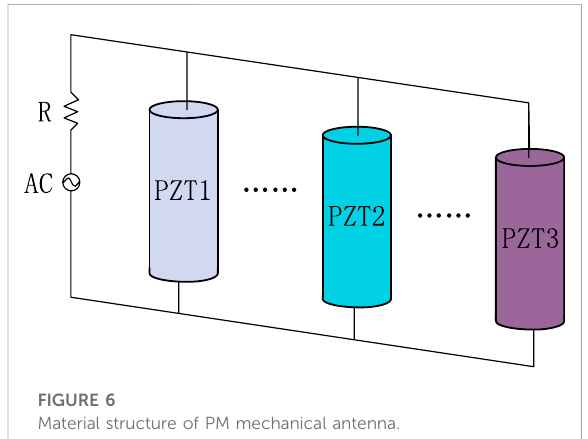
FIGURE 6 Material structure of PM mechanical